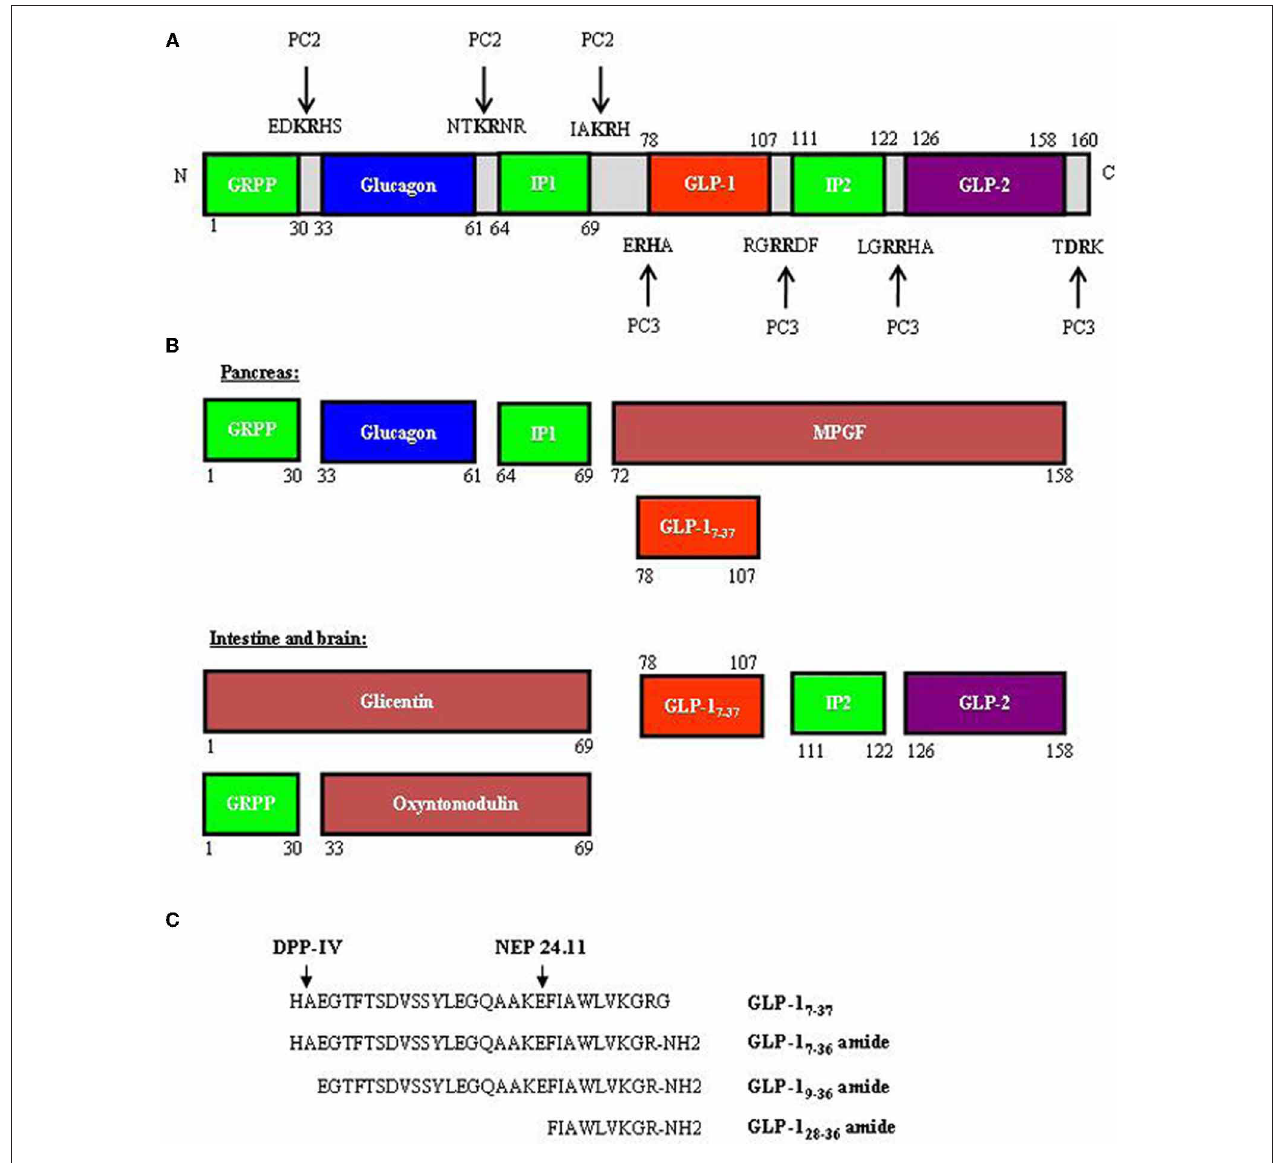
FIGURE 2 | Proglucagon and its cleavage products (proglucagon derived peptides, PGDPs) including GLP-1. (A) Proglucagon, encoded by gcg , is a pro-hormone with 160 amino acid residues. The peptide contains both PC2 and PC3 cleavage sites. (B) A schematic presentation of the cleavage products in the pancreas (top) and in the intestine and brain (bottom). Although GLP-1 is not normally produced in the pancreas, during the embryonic stage or when islets are under